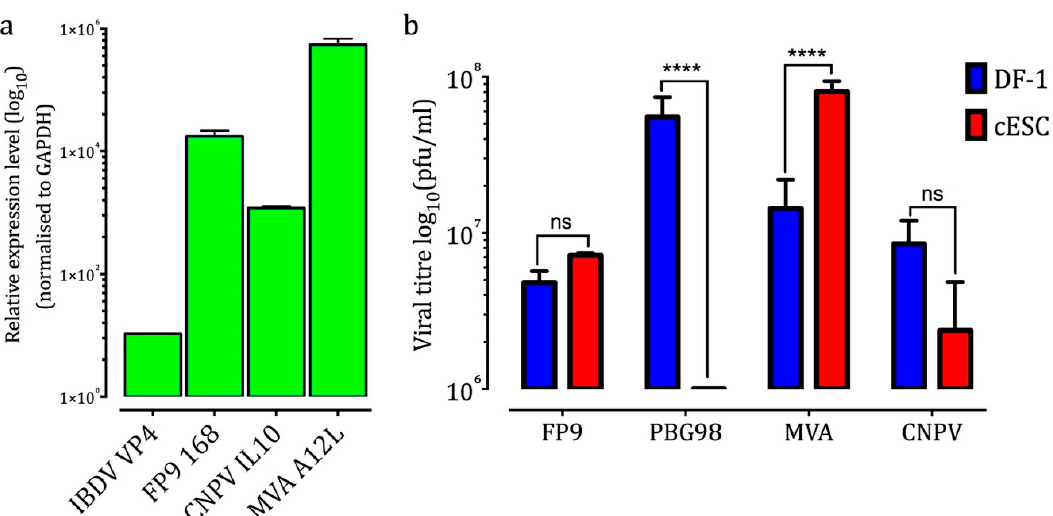
Figure 3. ( a ) Fold change of viral genes (related to mock-infected samples and normalised against